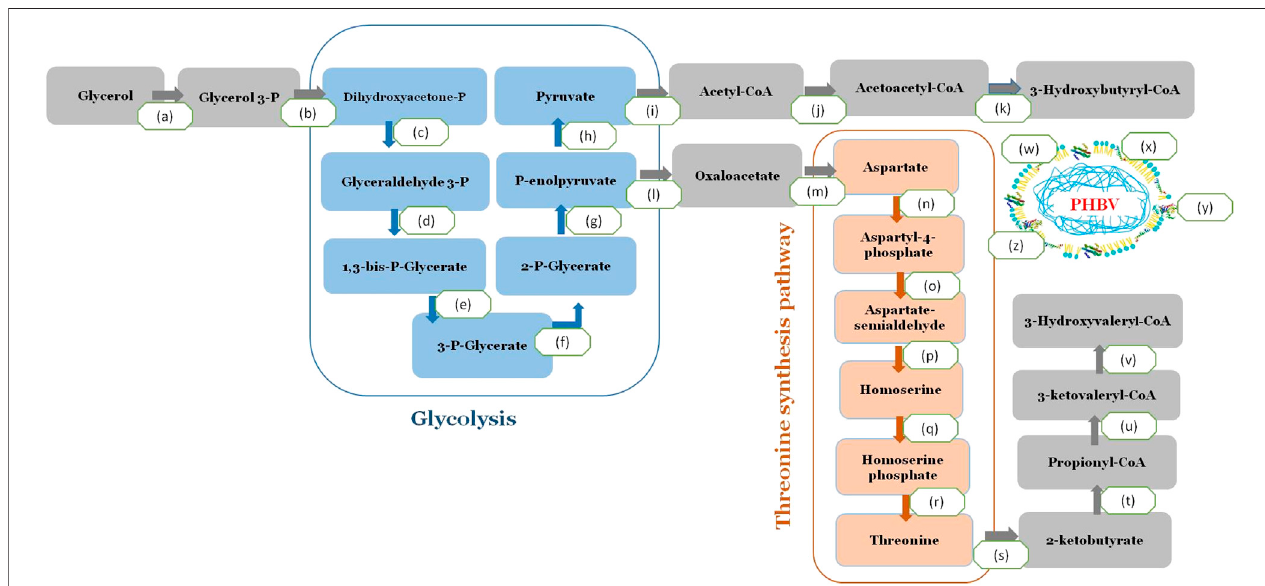
FIGURE 5 | A complete pathway for converting glycerol to PHBV in H. desertis genome. (a) Glycerol kinase, EC 2.7.1.30, glpK, A0A1A0F938, (b) Glycerol-3- phosphatedehydrogenase,EC1.1.5.3(A0A1A0F0A7)(c)Triosephosphateisomerase,EC5.3.1.1(A0A1A0FLG5)(d)Glyceraldehyde-3-phosphatedehydrogenase,EC 1.2.1.12, (A0A1A0FJ82, A0A1A0FBT9, A0A1A0FMC5, A0A1A0F5L9) (e) Phosphoglycerate kinase, EC 2.7.2.3 (A0A1A0F555) (f) 2,3-bisphosphoglycerate- independent phosphoglycerate mutase, EC 5.4.2.12 (A0A1A0FLZ7) (g) Enolase, EC 4.2.1.11 (A0A1A0EWM0), (h) Pyruvate kinase, EC 2.7.1.40 (A0A1A0EQ50, A0A1A0FJ83) (i) Pyruvate dehydrogenase, EC 1.2.4.1 (A0A1A0FHI0) (j) 3-ketoacyl-CoA thiolase (phaA), EC 2.3.1.16 (A0A1A0FJC6) Acetyl-CoA acetyltransferase (EC 2.3.1.9) (A0A1A0FLF6, WP_066316105.1) (k) acetoacetyl-CoA reductase EC 1.1.1.36 (phaB) (A0A1A0FCW9, WP_066319309.1), (l) Class I poly(R)-hydroxyalkanoic acid synthase, EC 2.3.1-(phaC) (A0A1A0ERQ1), (m) Polyhydroxyalkanoate depolymerase (EC 3.1.1.75/76) (A0A1A0FL46) (PhaZ), (n) Phasin family proteins (A0A1A0ERX1, A0A1A0FMH7, A0A1A0EQ92A0EQ92) and (o) Polyhydroxyalkanoate synthesis repressor (PhaR) (A0A1A0EWK0), (p) Homoserine dehydrogenase